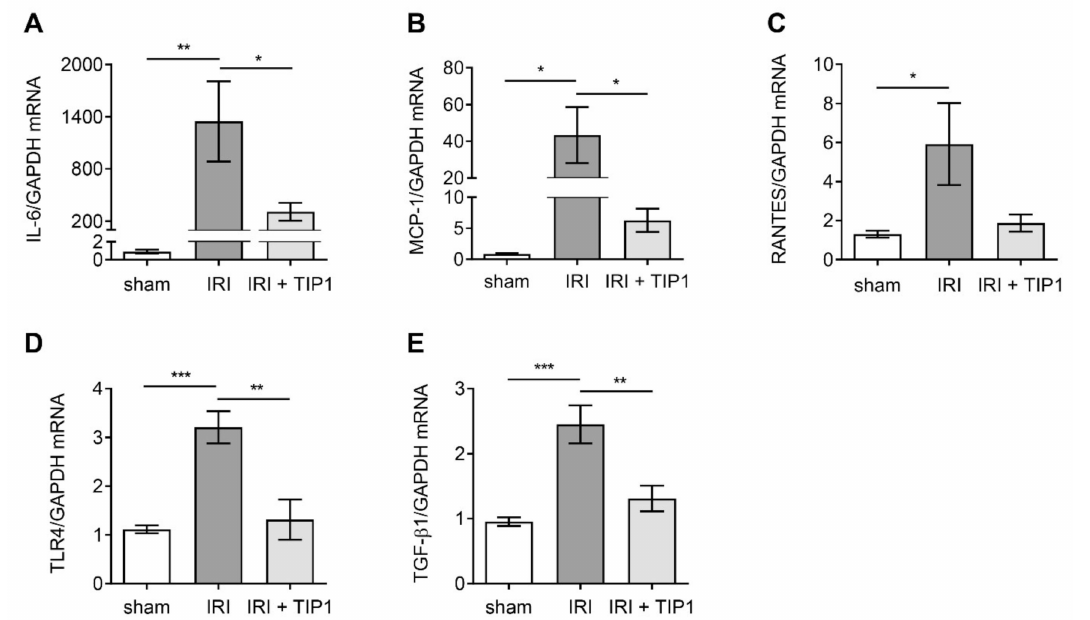
Figure 4. Inhibitory effect of TIP1 on proinflammatory cytokine and chemokine following kidney ischemia-reperfusion injury. mRNA expression of IL-6 ( A ), MCP-1 ( B ), RANTES ( C ), TLR4 ( D ), and TGF- β 1 ( E ) in kidney tissue. Kidney tissues were harvested from sham ( n = 6), IRI ( n = 6), and IRI-TIP1 ( n = 6) groups 24 h after IRI. Data are expressed as mean ± SEM. * p < 0.05, ** p < 0.01, and *** p < 0.001. Interleukin-6 (IL-6); monocyte chemoattractant protein-1 (MCP-1); regulated on activation, normal-T-cell-expressed and -secreted (RANTES); Toll-like receptor 4 (TLR4); transforming growth factor- β 1 (TGF- β